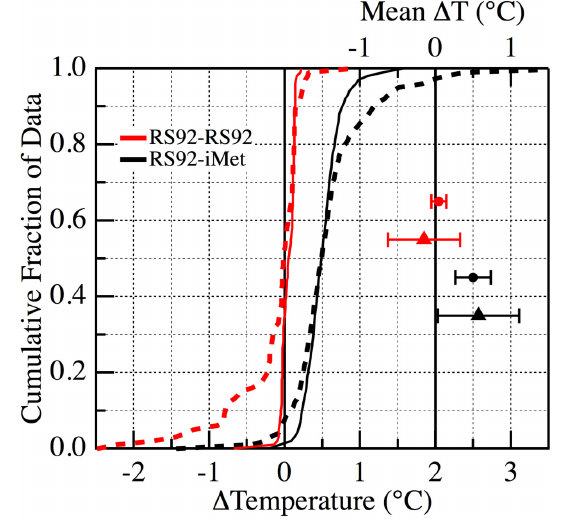
Fig. 4. Cumulative distribution functions and Gaussian statistics for RS92-RS92 1T (red) and RS92-iMet 1T (black). CDF data frac- tions (left axis) are associated with the bottom axis scale. CDFs of RS92-iMet 1T in all profiles (dashed) and in the majority of profiles (solid) are positively offset from zero and show inner-68% ranges that do not include zero, signifying that the median 1T val- ues ( ∼ 0.5 ◦ C) are statistically different from zero. To the right of the CDFs, means (markers) and standard deviations (error bars) of 1T are presented for all profiles (triangles) and for the majority of profiles (dots), using the top axis scale. The standard deviation ranges for RS92-iMet 1T (black) do not include zero, revealing mean 1T values ( ∼ 0.5 ◦ C) that are statistically different from zero. Black vertical lines at 1T =0 (for both axes) are included as visual